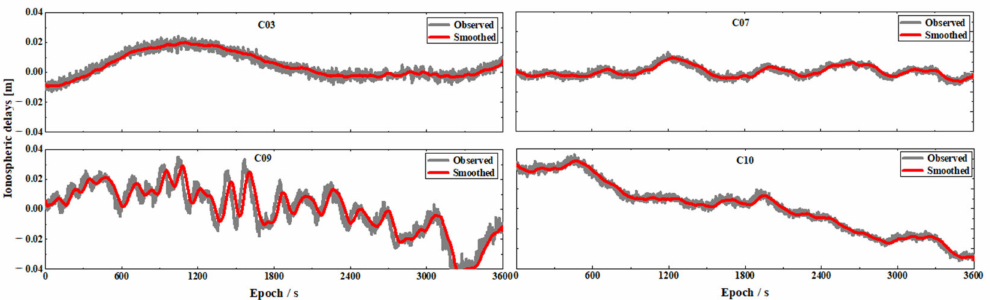
Figure 4. Comparison of the observed ionospheric delays, smoothed ones with a moving window width of 60